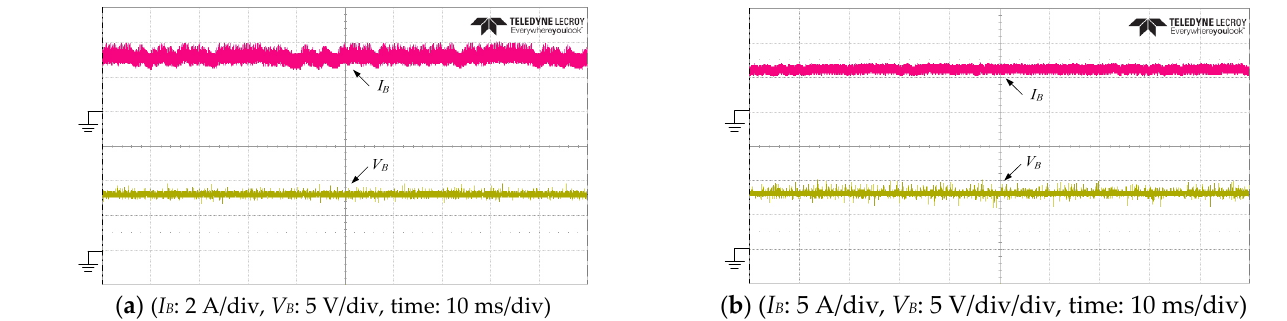
Figure 22. Measured battery voltage V B and current I B waveforms of the proposed hybrid converter operated in the utility line condition ( a ) under I B = 3 A and ( b ) under I B = 6 A.